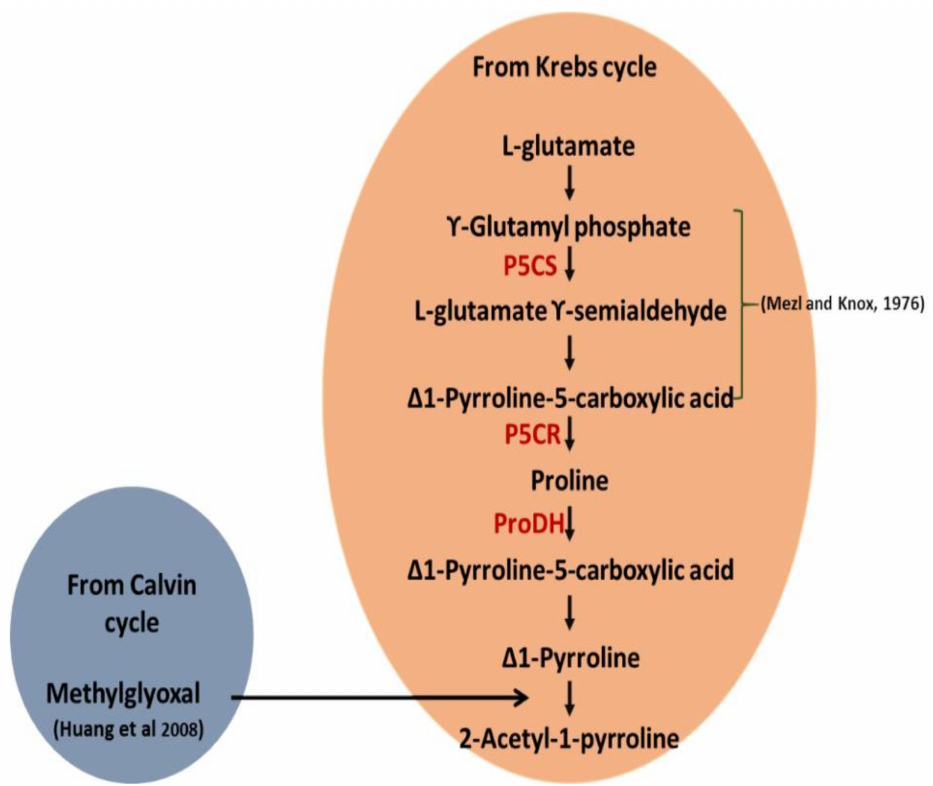
Figure 8. Proposed 2AP biosynthetic pathway in P. amaryllifolius , highlighting enzymes used in biosynthesis of 2AP in P. amaryllifolius.P5CS : ∆ 1-pyrroline-5-carboxylate synthetase; P5CR: ∆ 1- pyrroline-5-carboxylate reductase; ProDH: proline